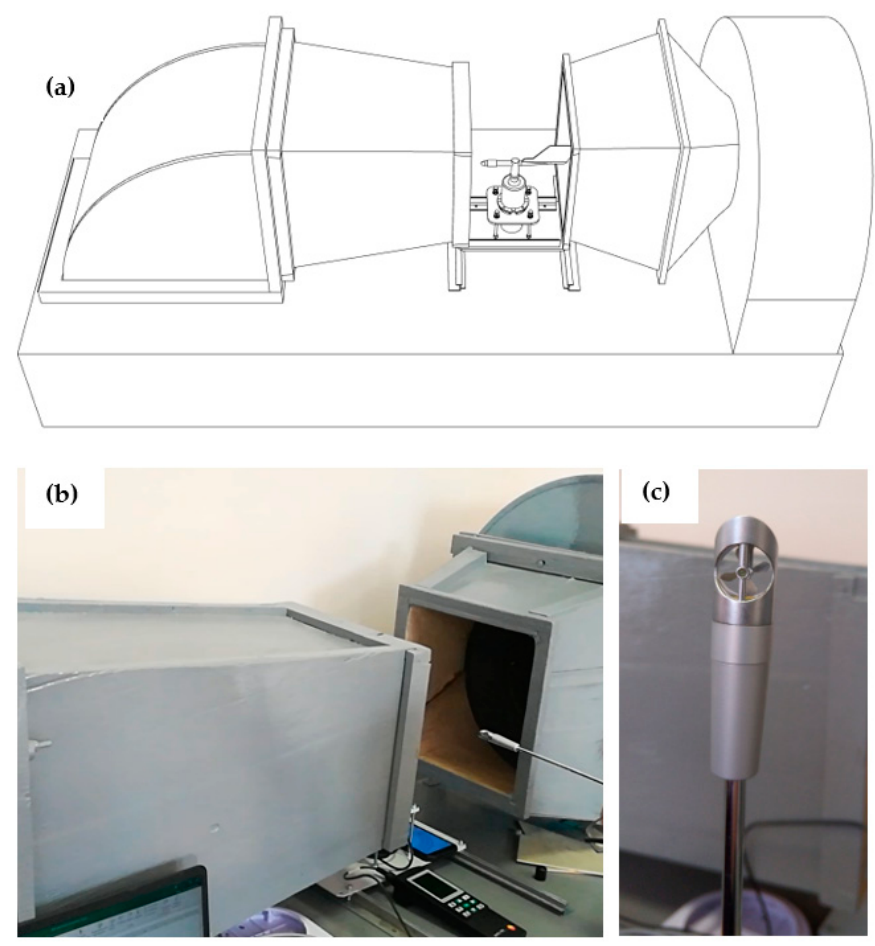
Figure 5. Aerodynamic pipe overall sketch ( a ), working area for the wind velocity measurements ( b ) and anemometer probe ( c ).